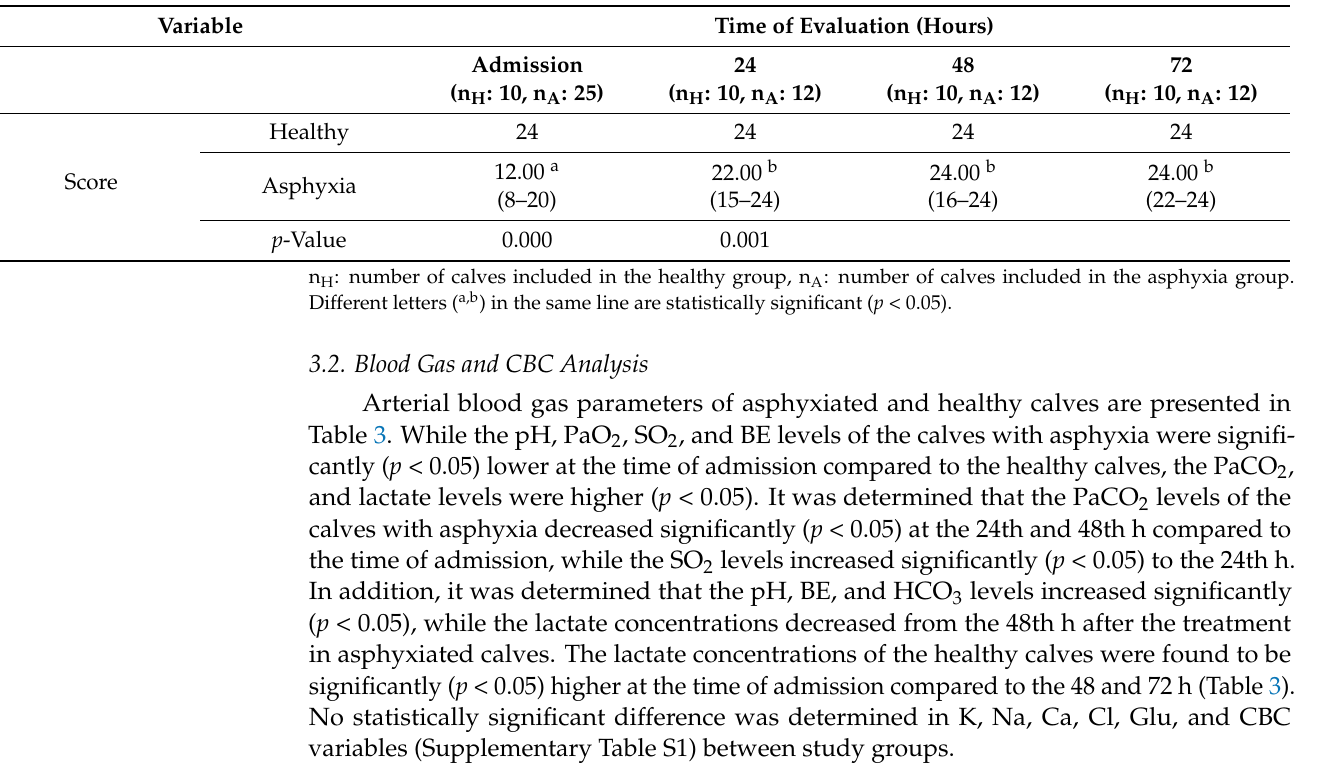
Table 2. Neurological status score in healthy and calves with perinatal asphyxia.